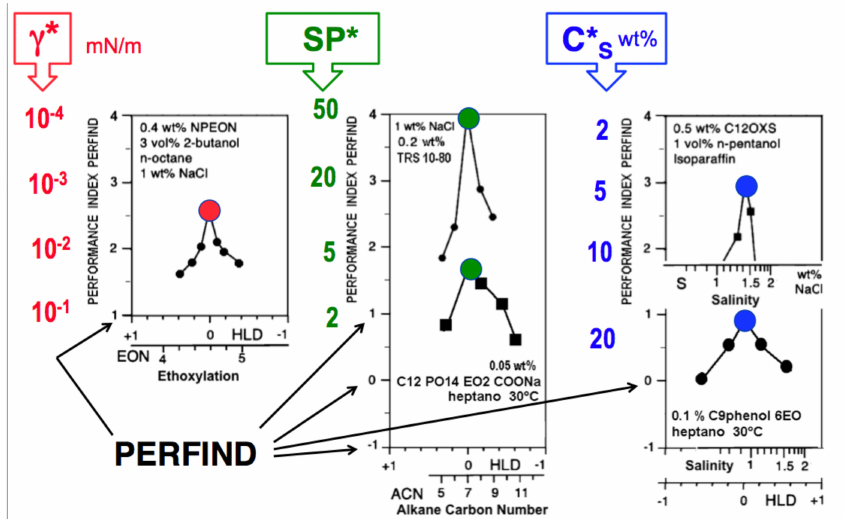
Figure 6. Detection of optimum formulation by di ff erent criteria maximizing the performance index PERFIND (minimum interfacial tension γ *, maximum solubilization parameter SP* and minimum surfactant spending C*s) to attain a single-phase microemulsion at the tail of the fish